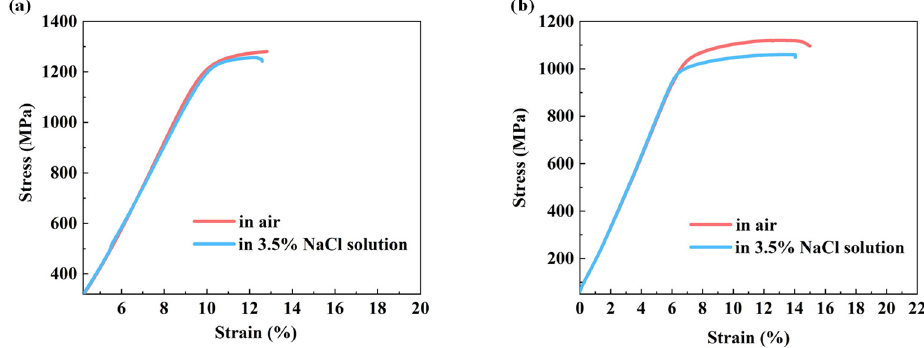
Figure 4. The stress–strain curves of SSRT, ( a ) AM1 alloys, ( b ) AM2 alloys.